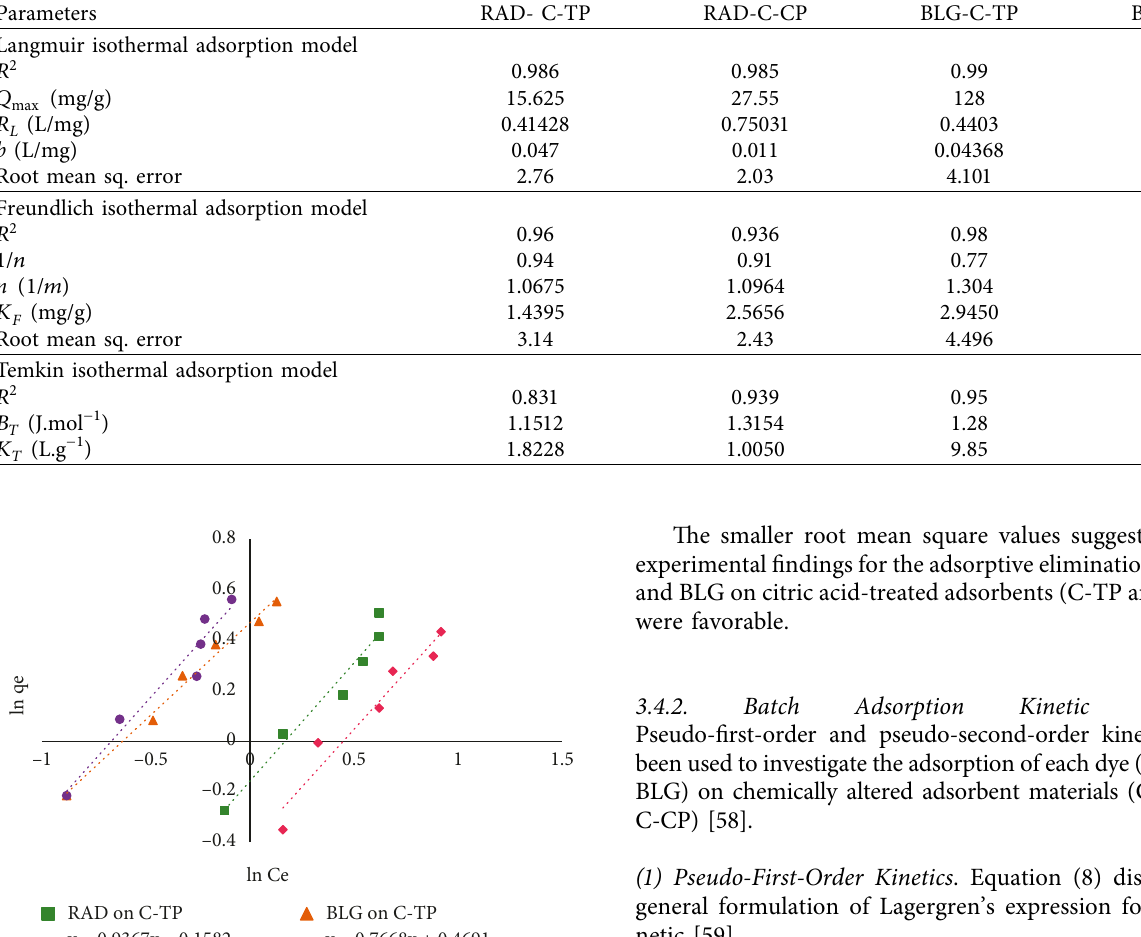
Table 3: A comparison of isothermal parameters for the adsorptive elimination of RAD and BLG on citric acid-treated adsorbents C-TP and C-CP. Parameters